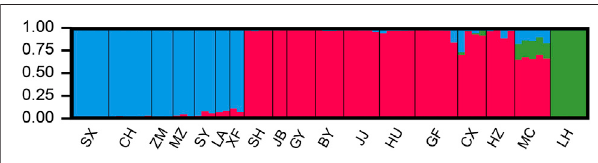
FIGURE 2 | The results of STUCTURE analysis of Odontobutis potamophilus populations based on 472 SNP loci. Red denotes the Qiantang and lower Yangtze group (QY), blue denotes the middle Yangtze group (MY), andgreendenotestheOujiangclade(OJ).Eachindividualisrepresented by a single bar. The different color on a single bar indicates admixture origin of the individual.